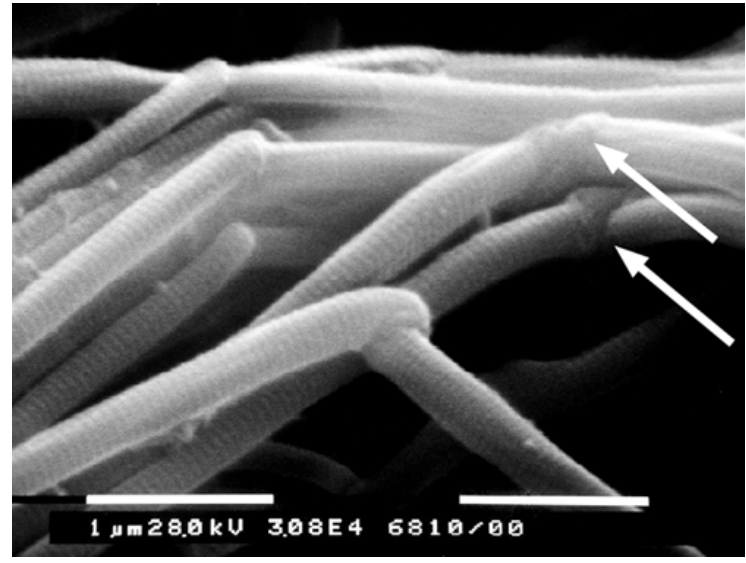
FIGURE 11. Electron micrograph of longitudinally sectioned rat tail tendon. Where fibrils change their direction, they loose their D-period (arrows). These knots have been termed “fibrillar crimps”. Bar = 1 μ